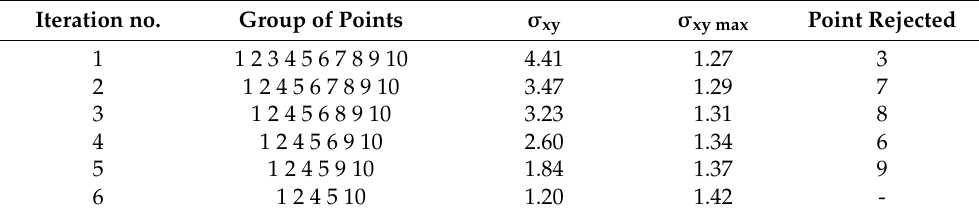
Table 2. The identification of the stability of reference system by congruency test for the test object 1. Iteration